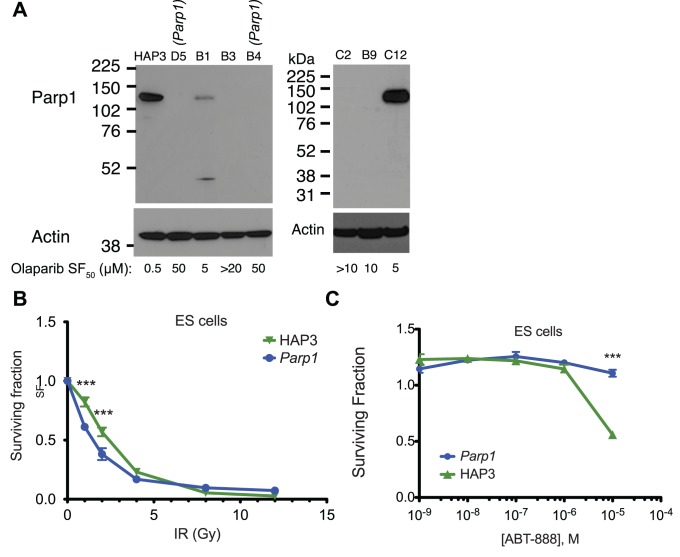
Other mutants isolated in the screen also lack Parp1 expression.
A. Other clones isolated in the olaparib resistance screen, which did not revert, have lost Parp1 protein expression. Lysates from the indicated cells were probed with anti-PARP or anti-β-actin antibodies as indicated. The same result was obtained in an independent experiment with a different antibody. Olaparib SF50 was calculated from dose response curves as in (B); >10 means growth was >50% relative to untreated cells at the highest concentration tested (e.g. 10 µM). B.
Parp1 mutant ES cells are not resistant to ionising radiation. Cells were irradiated with the indicated dose one day after plating and assayed for growth five days later. C.
Parp1 mutant cells are also resistant to the PARP inhibitor ABT-888 (veliparib) at high doses. n = 5, mean and SEM shown, ***; P<0.001.